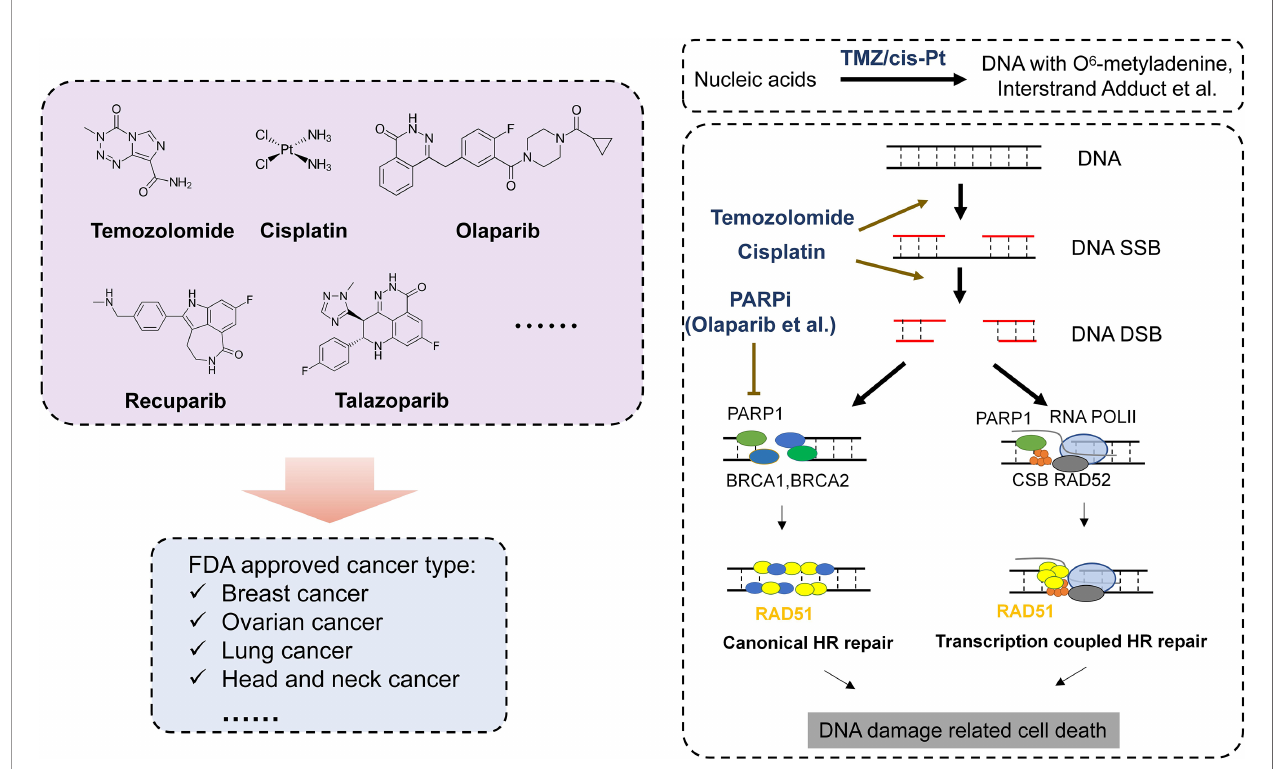
FIGURE 1 | DDR drugs and mechanism of DDR drug in cancer treatment. Left: Represent FDA-approved DNA damage-related drugs. Right: Mechanism of DDR drugs in DNA repair